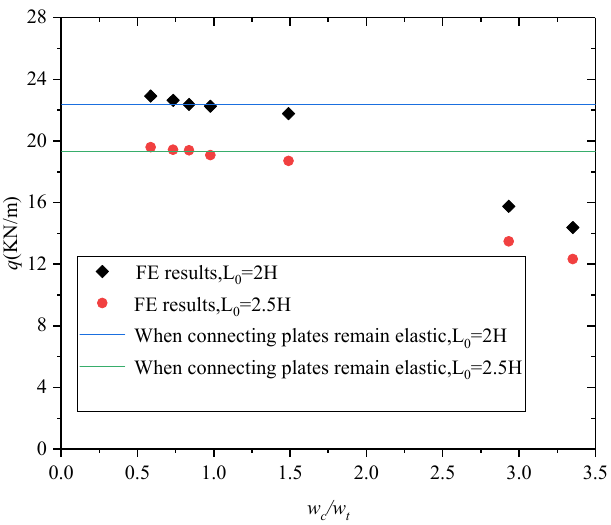
Figure 28. Effect of connecting plate size on the ultimate bearing capacity of local failure mode.